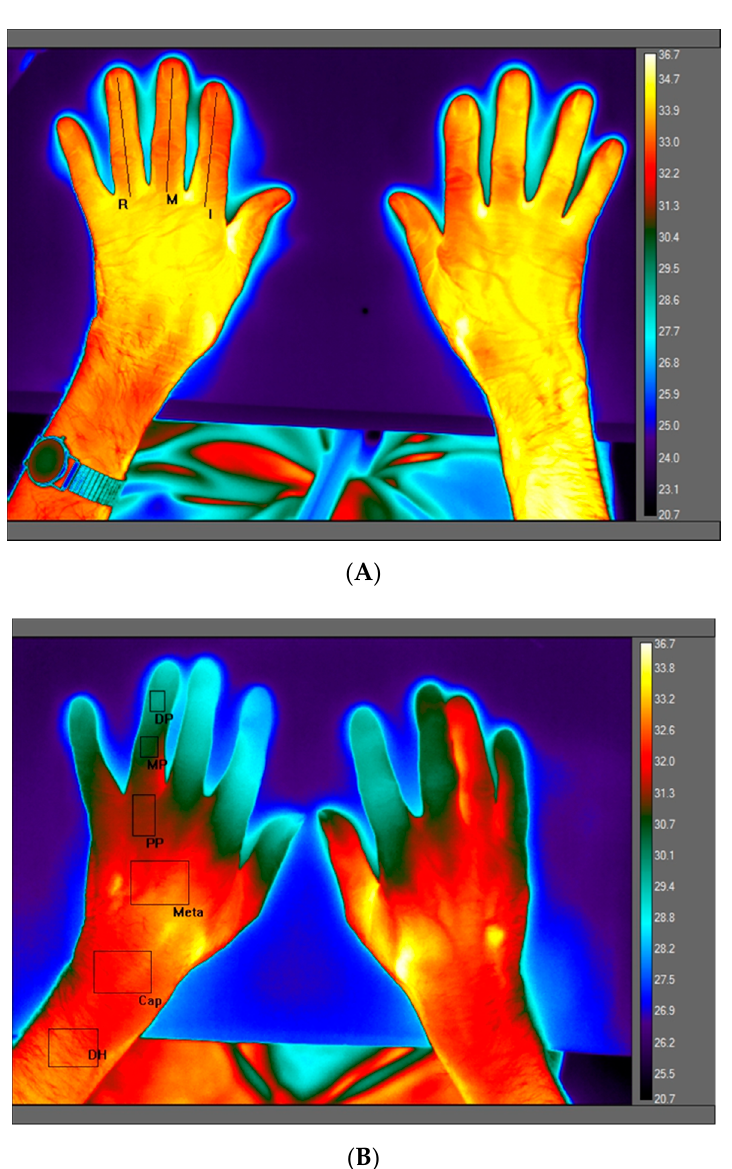
Figure 2. ( A ): Thermal map of left and right hand positioned upon an insulated tile. The region of interest (ROI, non-dominant hand) displayed as a vertical line constructed centrally for ring (R), middle (M) and index (I) fingers. Selection of the finger with greatest variability was used to construct six ‘box’ ROIs from which mean ROI values were obtained (B) and with data from the selected finger used in subsequent analyses. ( B ) shows anatomical ROI positions for temperature (°C) of distal phalange (T DP ), middle phalange (T Tmp ), proximal phalange (T PP ), metacarpal (T Meta ), capitate bones (T Cap ) and distal humerus (T DH ).